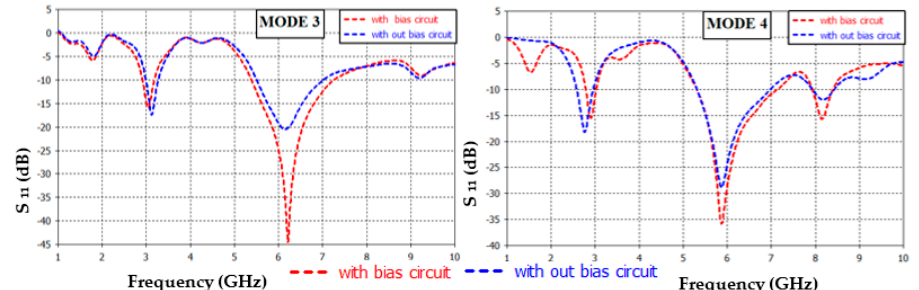
Figure 4. S 11 in the case of the bias circuit and the absence of this circuit.